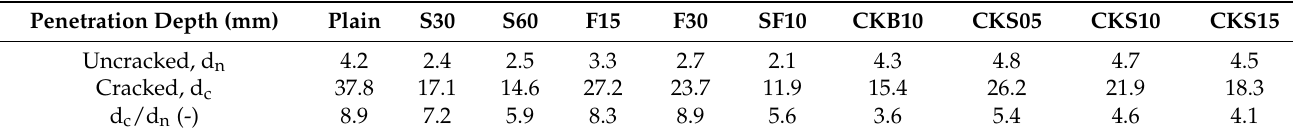
Table 4. Chloride ion penetration depth of the